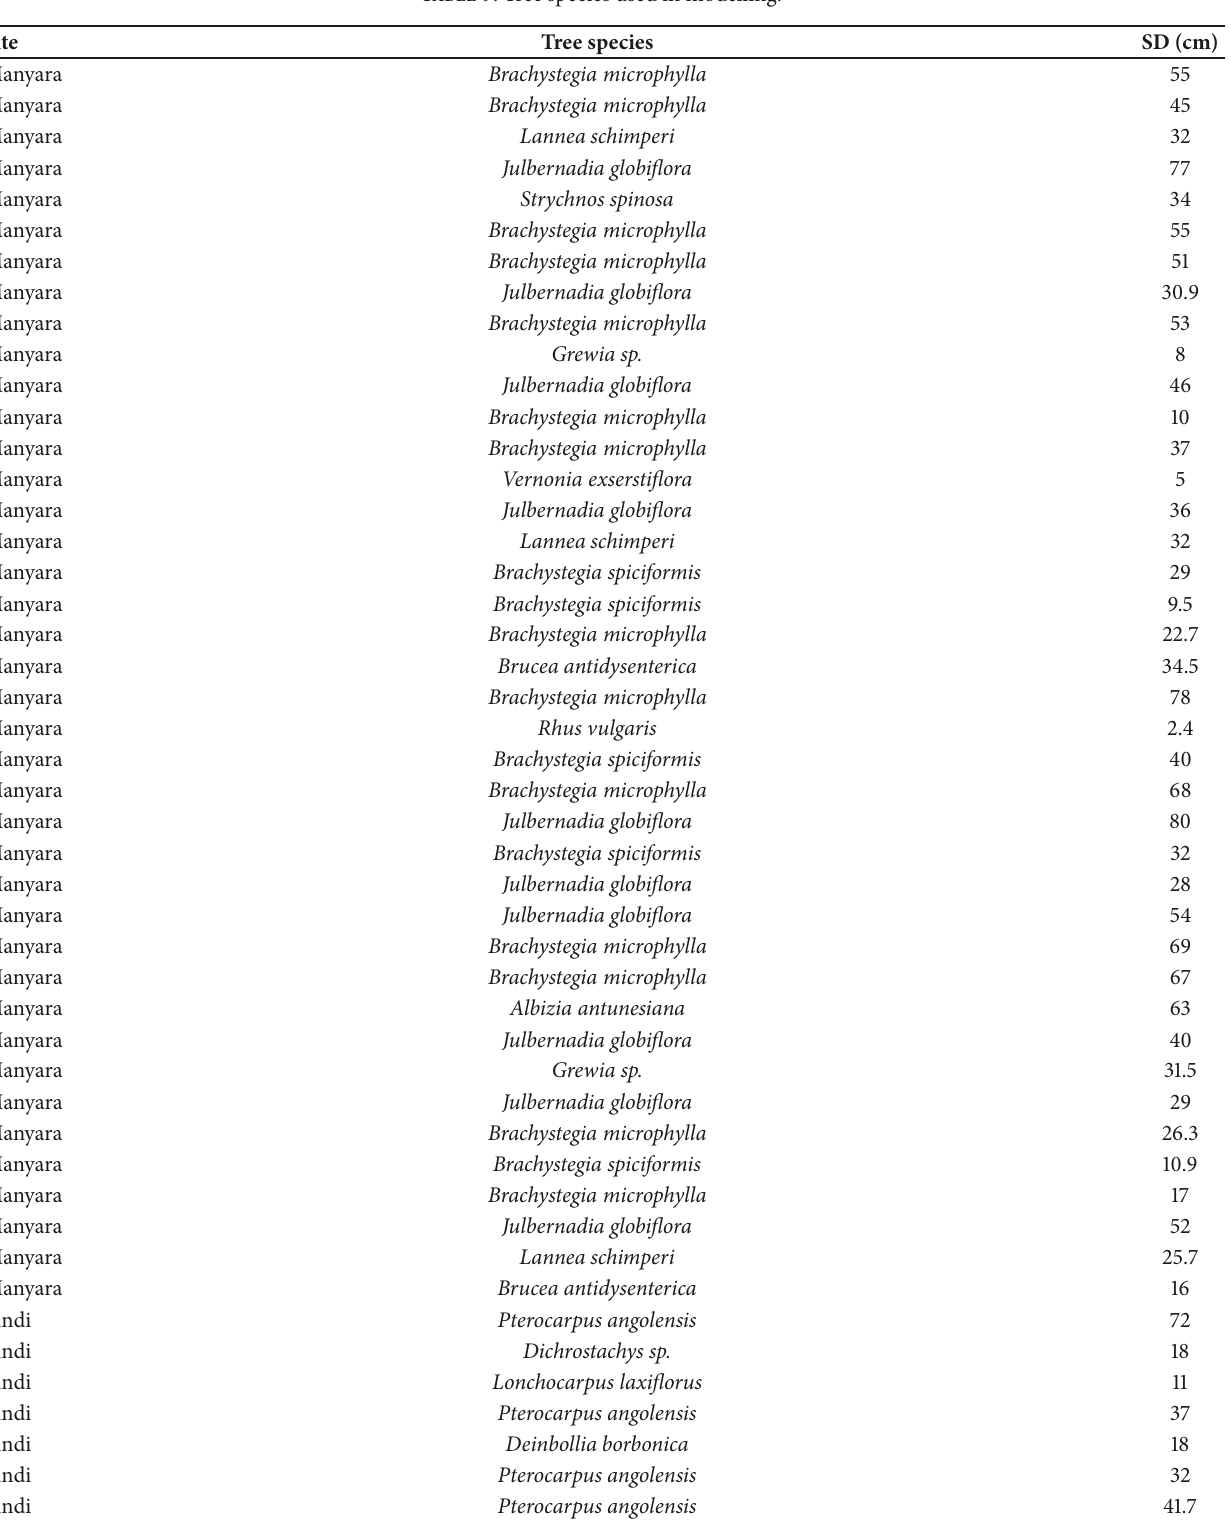
Table 9: Tree species used in